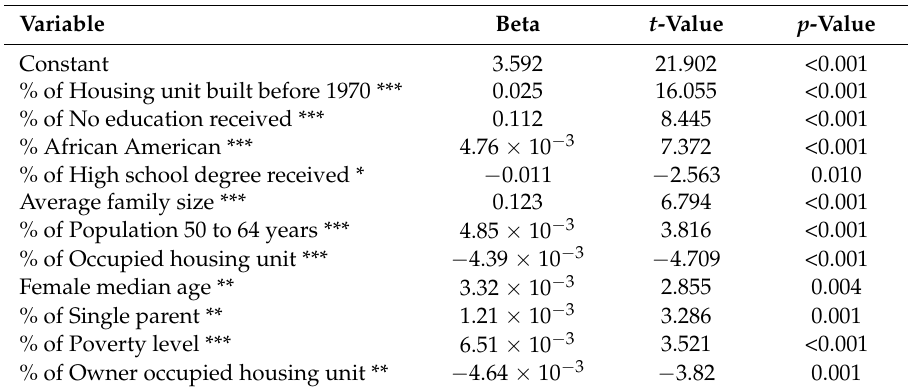
Table 5. Estimated results of regression models of pollution hazard intensity, as a function of socioeconomic profiles; OLS